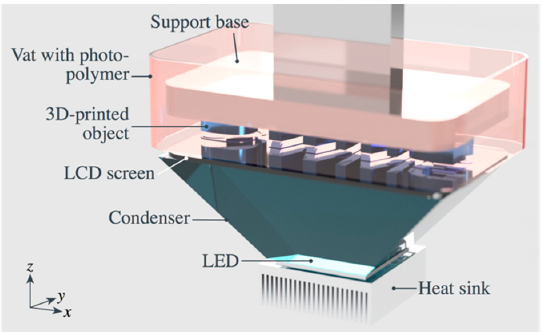
Figure 1. Schematic of the daylight LCD 3D printer. The photopolymer is cured at the bottom of the vat by the VIS blue light emitted by the LED source and masked through the LCD screen.